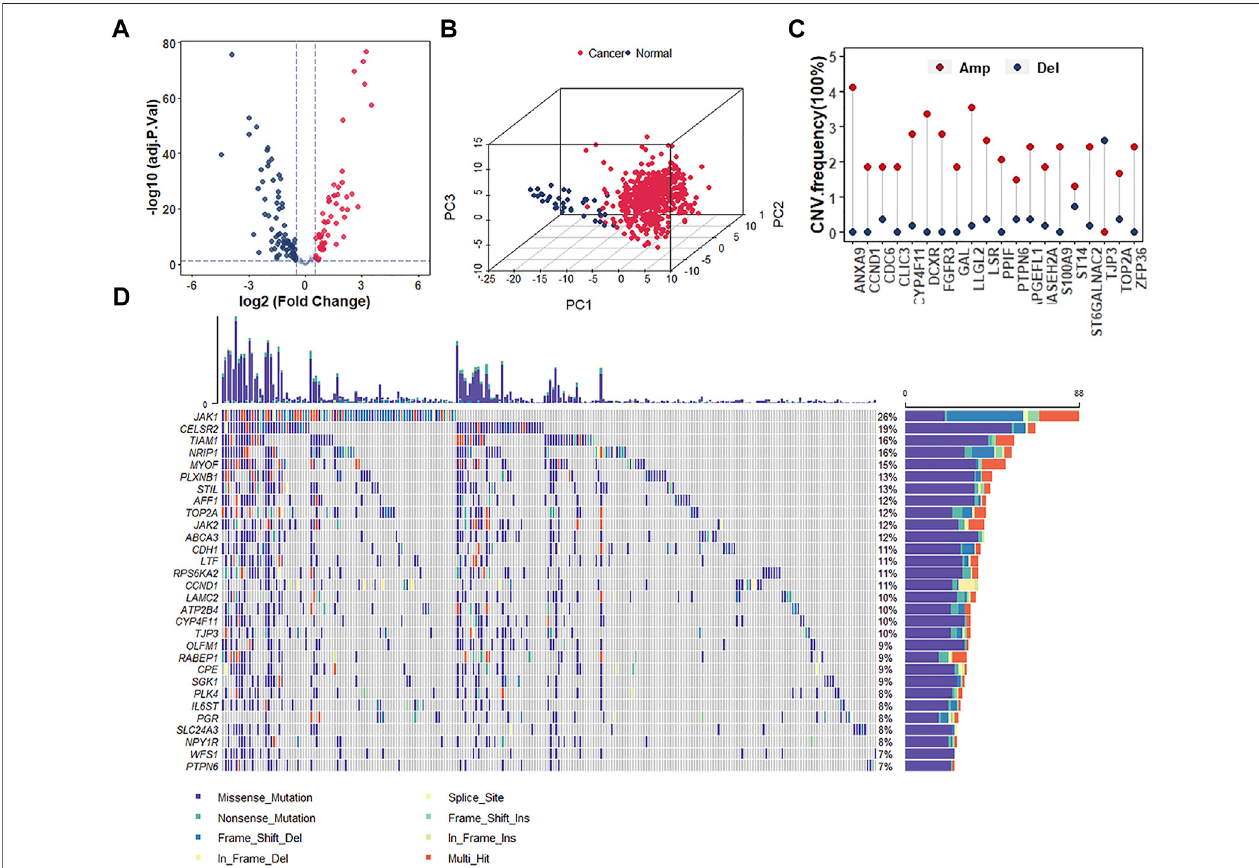
FIGURE3| Analysesofthedifferentiallyexpressedgenesandgenomicalterationsintheestrogenresponsepathway. (A) VolcanoplotrepresentingtheDEERGsin estrogenresponsepathwaybetweennormalandUCECsamples. (B) Principalcomponentanalysis(PCA)indicatingtheexpressionpro fi lesof132DEERGssbeingable to distinguish UCEC tumors from normal samples. (C) The CNV frequency of the top 20 DEERGs in the estrogen response pathway in TCGA-UCEC. (D) The mutation frequency of the top 30 DEERGs in the estrogen response pathway in TCGA-UCEC.